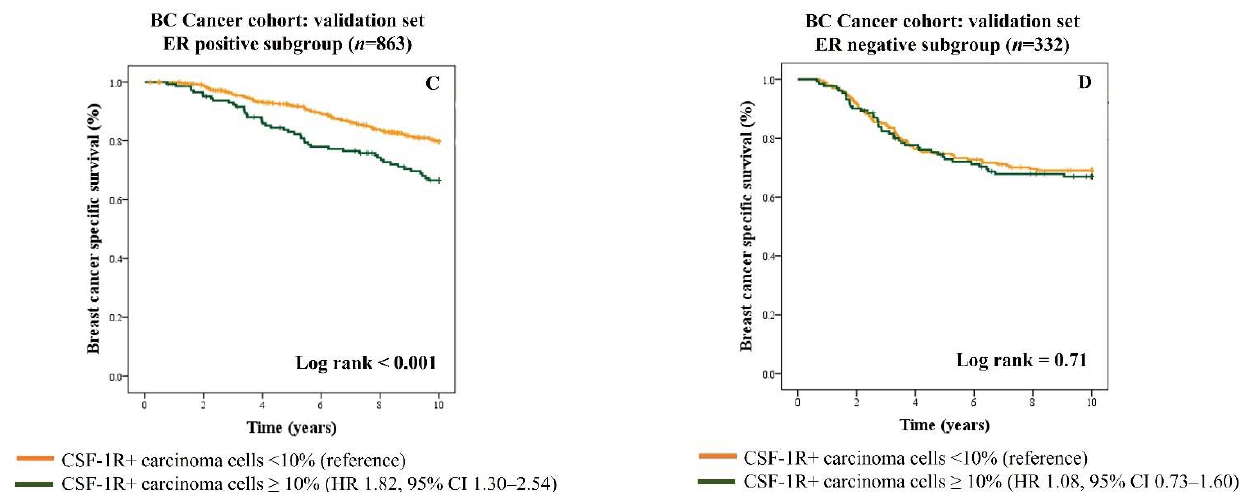
Figure 3. Kaplan–Meier survival curves showing breast cancer-specific survival in the validation set of BC Cancer series stratified by CSF-1R+ carcinoma cells ( A ) and CSF-1R+ tumor-associated macrophages ( B ). Prespecified subgroup analysis for CSF-1R-expressing carcinoma cells in ER-positive cases ( C ) and ER negative cases ( D ). Table 3. Multivariate analysis for CSF-1R+ carcinoma cells in the validation set of BC Cancer cohort. Co-Variates in the Model